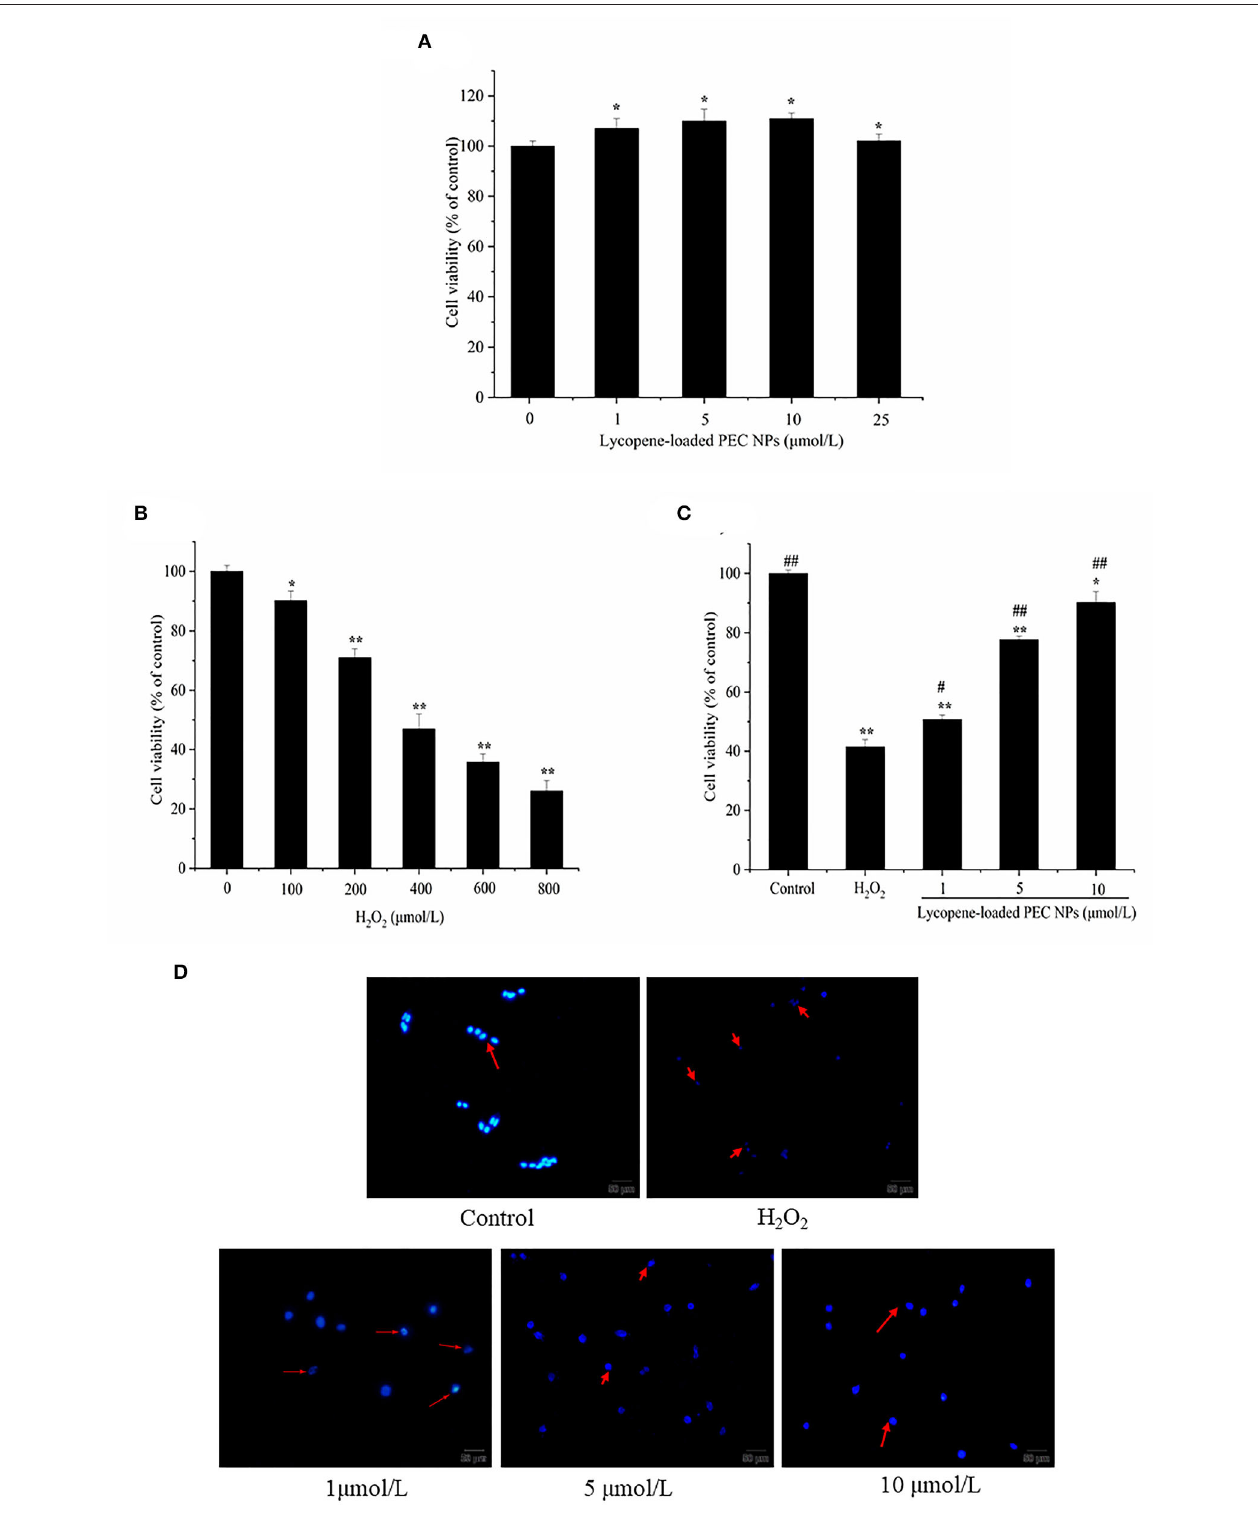
FIGURE 10 | Lycopene-loaded PEC NPs inhibit H 2 O 2 -induced cell apoptosis. (A) Cytotoxicity of lycopene-loaded PEC NPs in cells at different concentrations. (B) The viability of H 2 O 2 -induced cells. (C) Effects of lycopene-loaded PEC NPs on the viability of L02 cells. (D) Morphological analysis of the nucleus in cells. Data (mean ± SD) represent three experimental replicates. * p < 0.05, ** p < 0.01, vs. control group. # p < 0.05, ## p < 0.01, vs. H 2 O 2 -treated group.